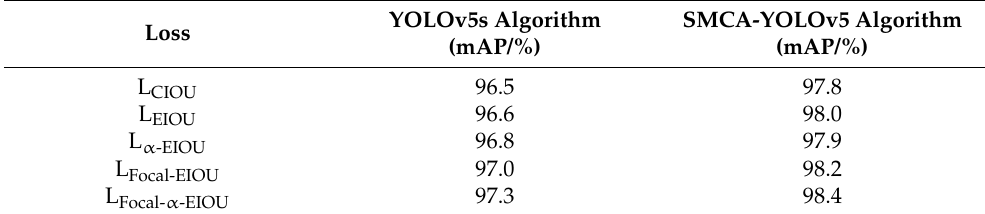
Table 3. Ablation experiment results under different losses.